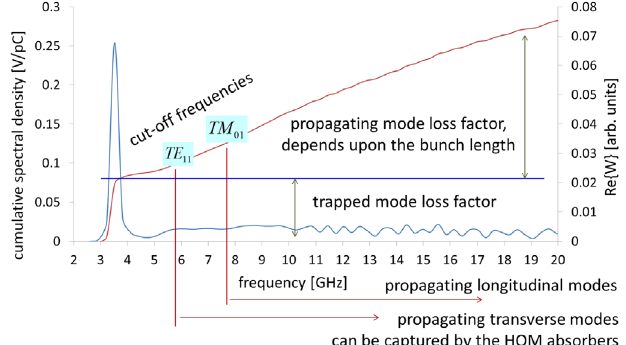
FIG. 16. A cumulative spectral density of the energy losses (red line) and a real part of the spectrum of the excited field (blue line). The horizontal blue line shows the level corresponds to the loss factor of the trapped mode. Above this level we have mainly propagating modes.